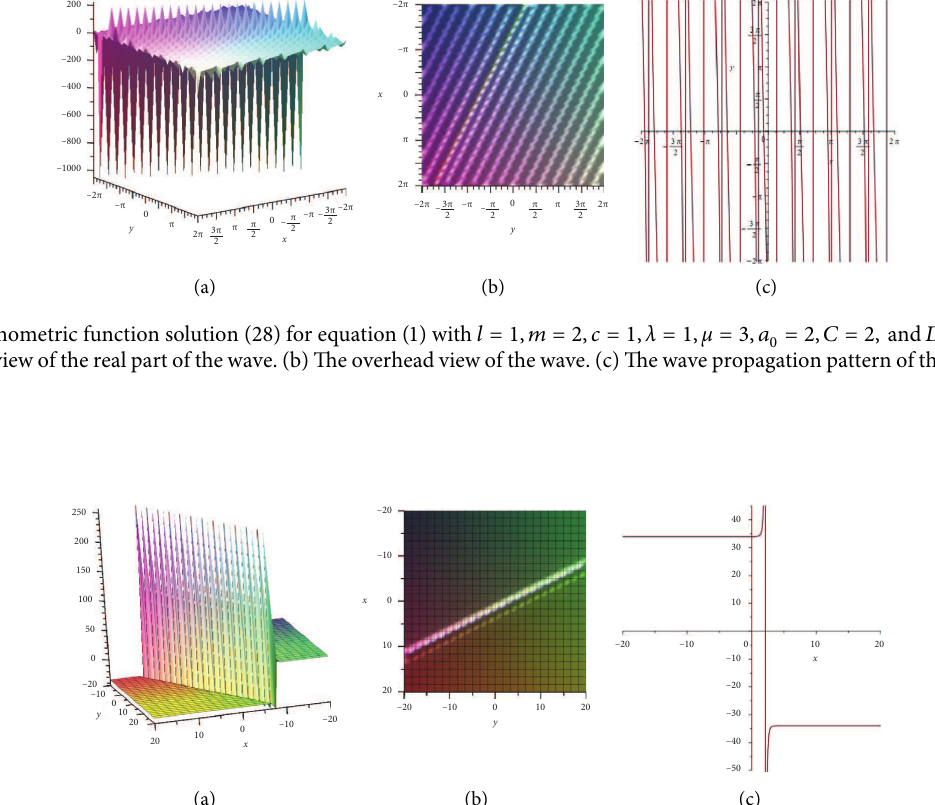
� 0 ,C � 1 , and D � 2 at time t � 2. (a) Per- 0